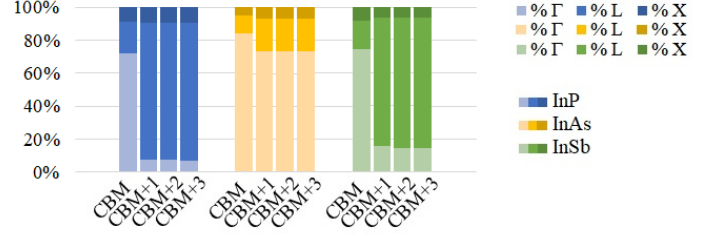
Figure 8. High symmetry points contribution to the CB states of InP, InAs and InSb QDs with anion-rich surfaces.